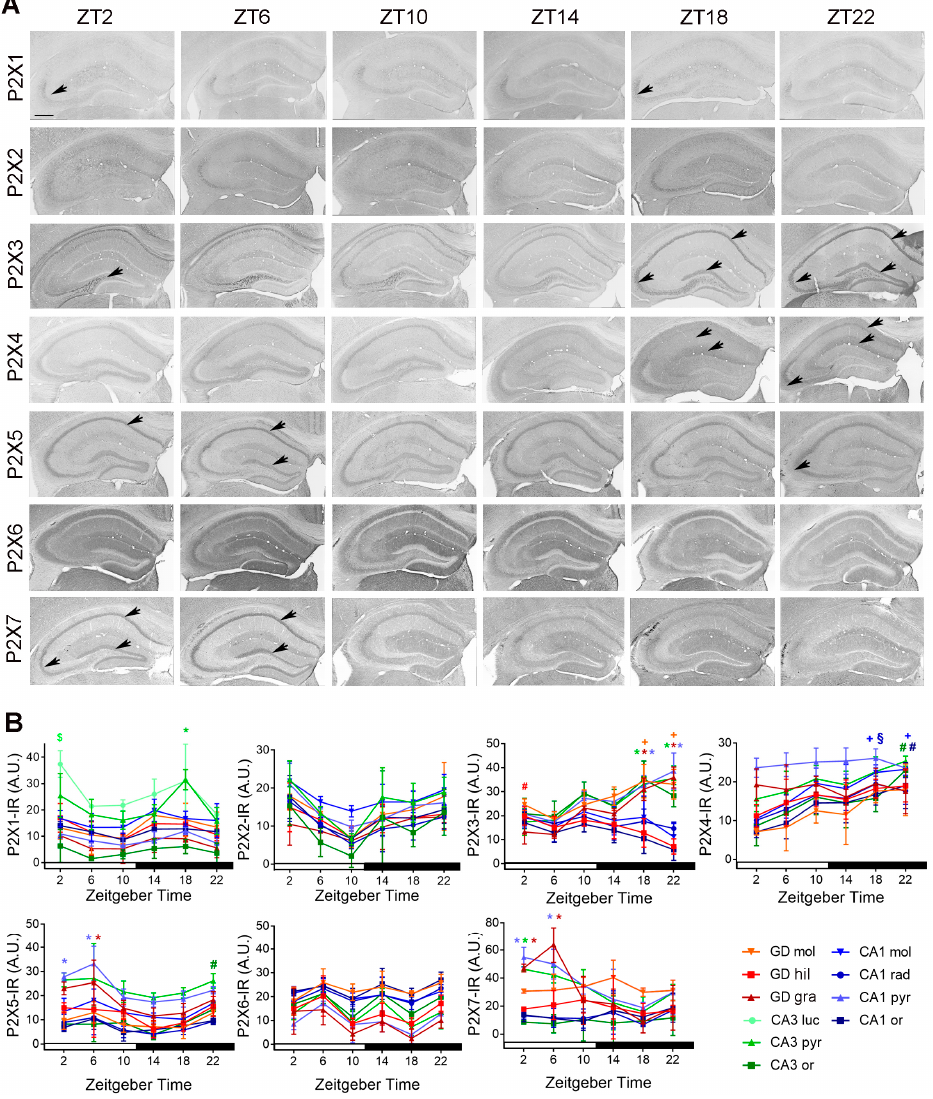
Figure 5. Temporal distribution of P2X-IR in the mouse hippocampus. ( A ) Representative microphotographs of P2X-IR in the hippocampus of mice killed at different zeitgeber times (ZT). Scale bar, 400 µm. ( B ) Quantitative analyses of P2X-IR in the hippocampal layers. Red, green, blue * indicate significantly ( p < 0.05 vs. through time) elevated levels in granule (gra) and pyramidal (pyr) cell layers of dentate gyrus, CA3 and CA1, respectively. Red, green, blue + indicate significantly ( p < 0.05 vs. through time) elevated levels in molecular (mol) cell layers of dentate gyrus, CA3 and CA1, respectively. Red, green, blue # indicate significantly ( p < 0.05 vs. through time) elevated levels in hilus (hil) and stratum oriens (ori) of dentate gyrus, CA3 and CA1, respectively. Red, green, blue § indicate significantly ( p < 0.05 vs. through time) elevated levels in stratum radiatum (rad) of CA1. Green $ indicates a significantly ( p < 0.05 vs. through time) elevated level in stratum lucidum (luc) of CA3. Shown are the mean+/ − arbitrary units (A.U.) of grey values above background of n = 3 mice per time point. Arrows indicate subregions of significantly high expression.